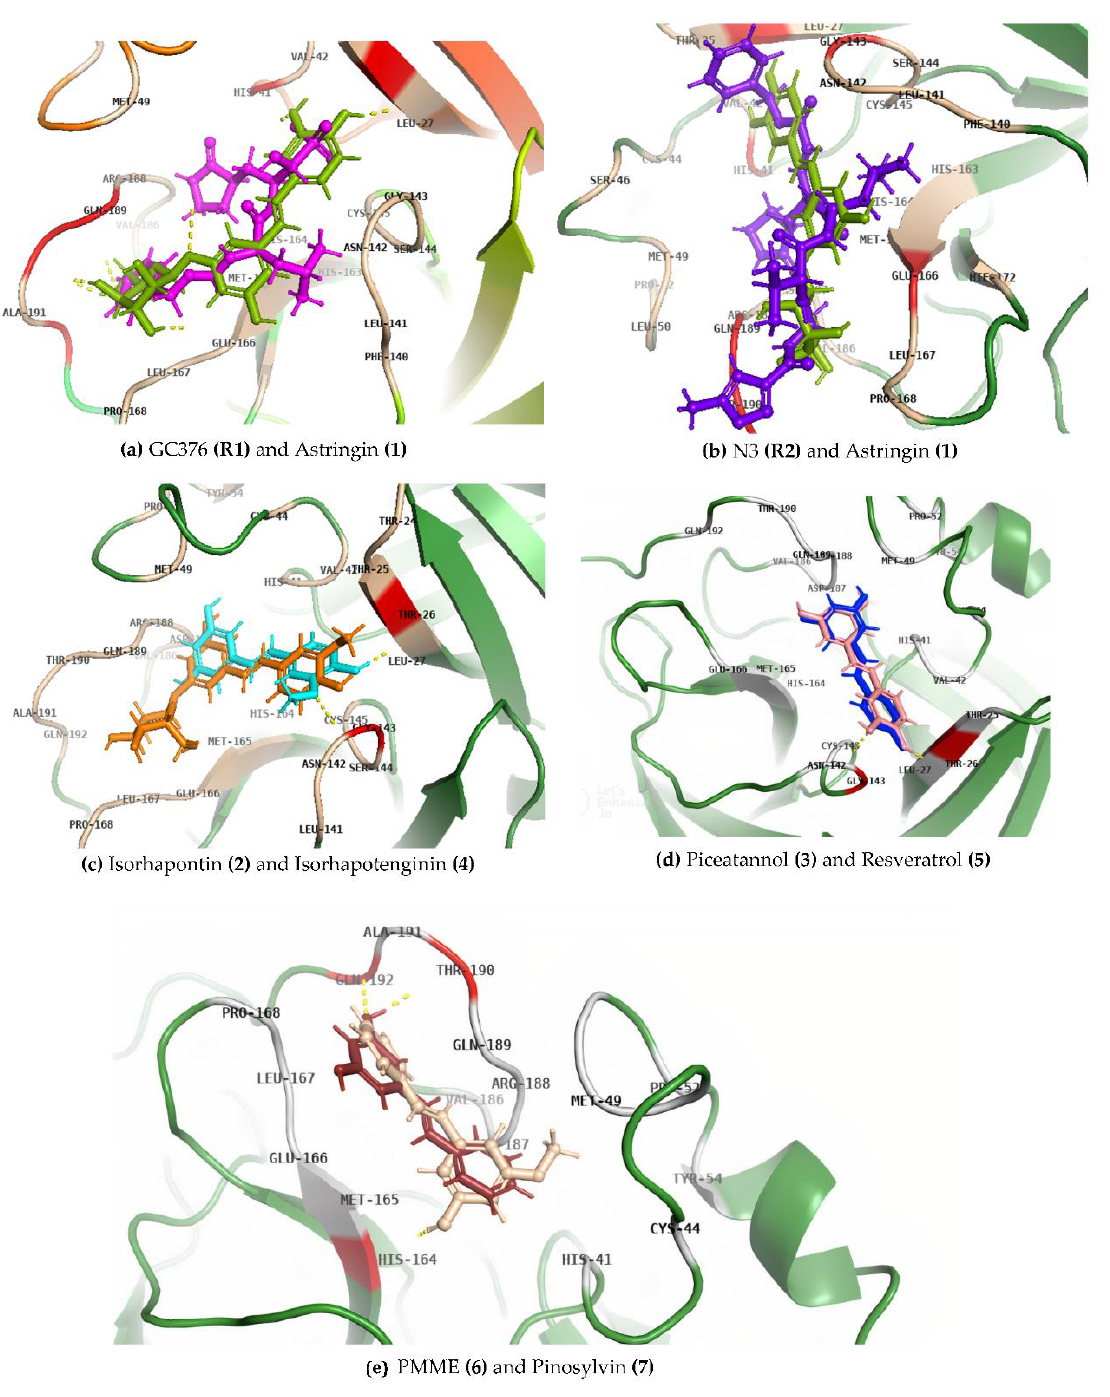
Figure 4. Overlapping docking configurations of ligands bound to M pro . GC376 (Reference 1) and Astringin (Structure 1) are shown in ( a ); N3 (Reference 2) and Astringin (Structure 1) in ( b ): Isorhapontin (Structure 2) and Isorhapotenginin (Structure 4) in ( c ); Piceatannol (Structure 3) and Resveratrol (Structure 5) in ( d ); PMME (Structure 6) and Pinosylvin (Structure 7) in ( e ).